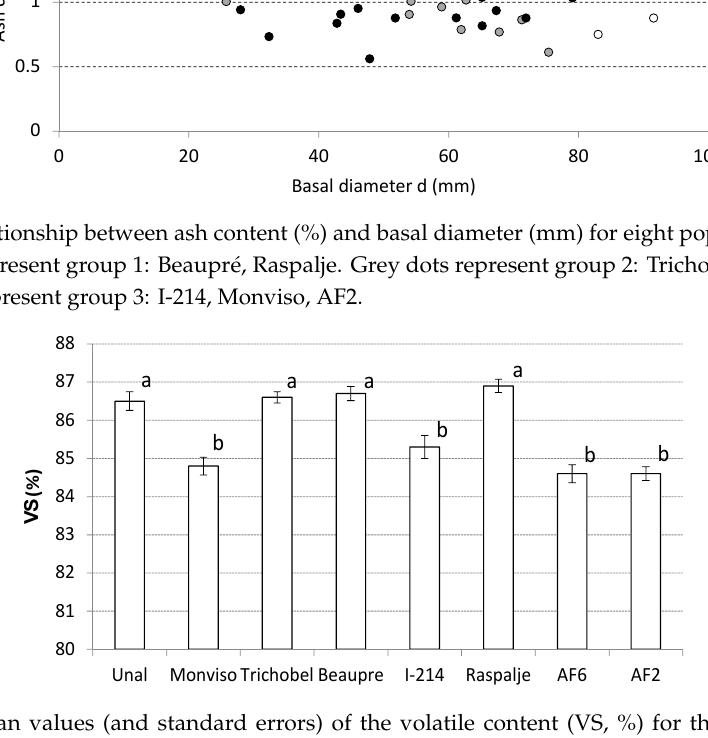
Figure 5. Mean values (and standard errors) of the volatile content (VS, %) for the eight poplar genotypes studied. Different letters denote significant differences (Tukey test).